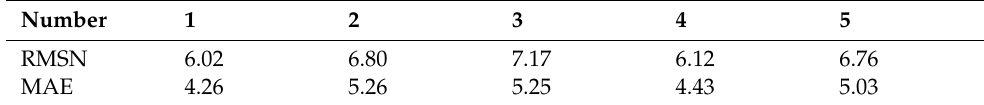
Table 9. Error result statistics of working condition 10003.